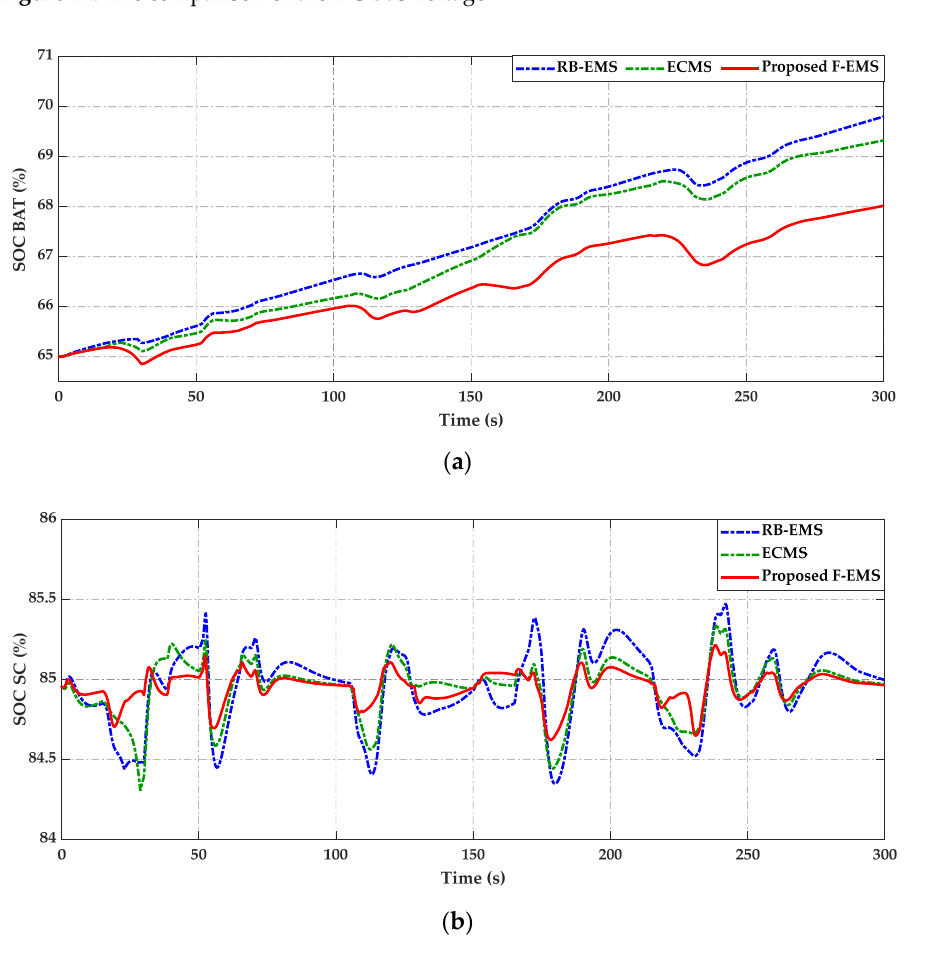
Figure 12. The SOC comparison. ( a ) BAT; ( b ) SC.